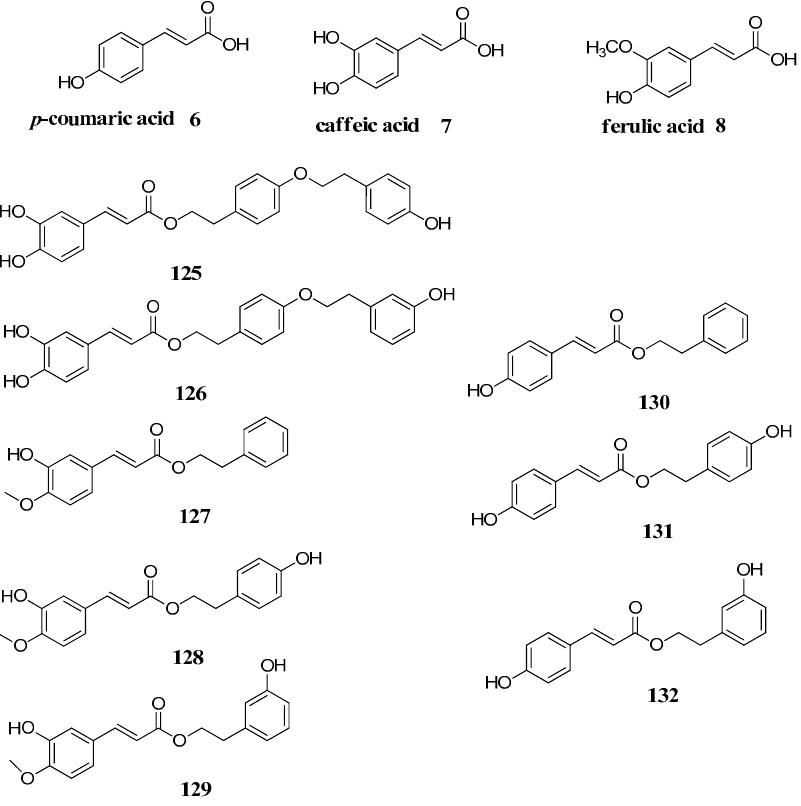
Figure 24. Structures of compounds 6 – 8 and derivatives 125 – 132 .